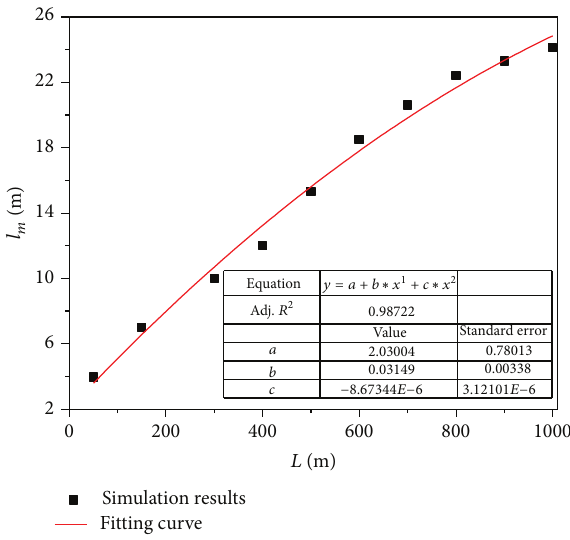
Figure 6: The maximum gas mixture length ( 𝑙 𝑚 ) versus the pipe length ( 𝐿